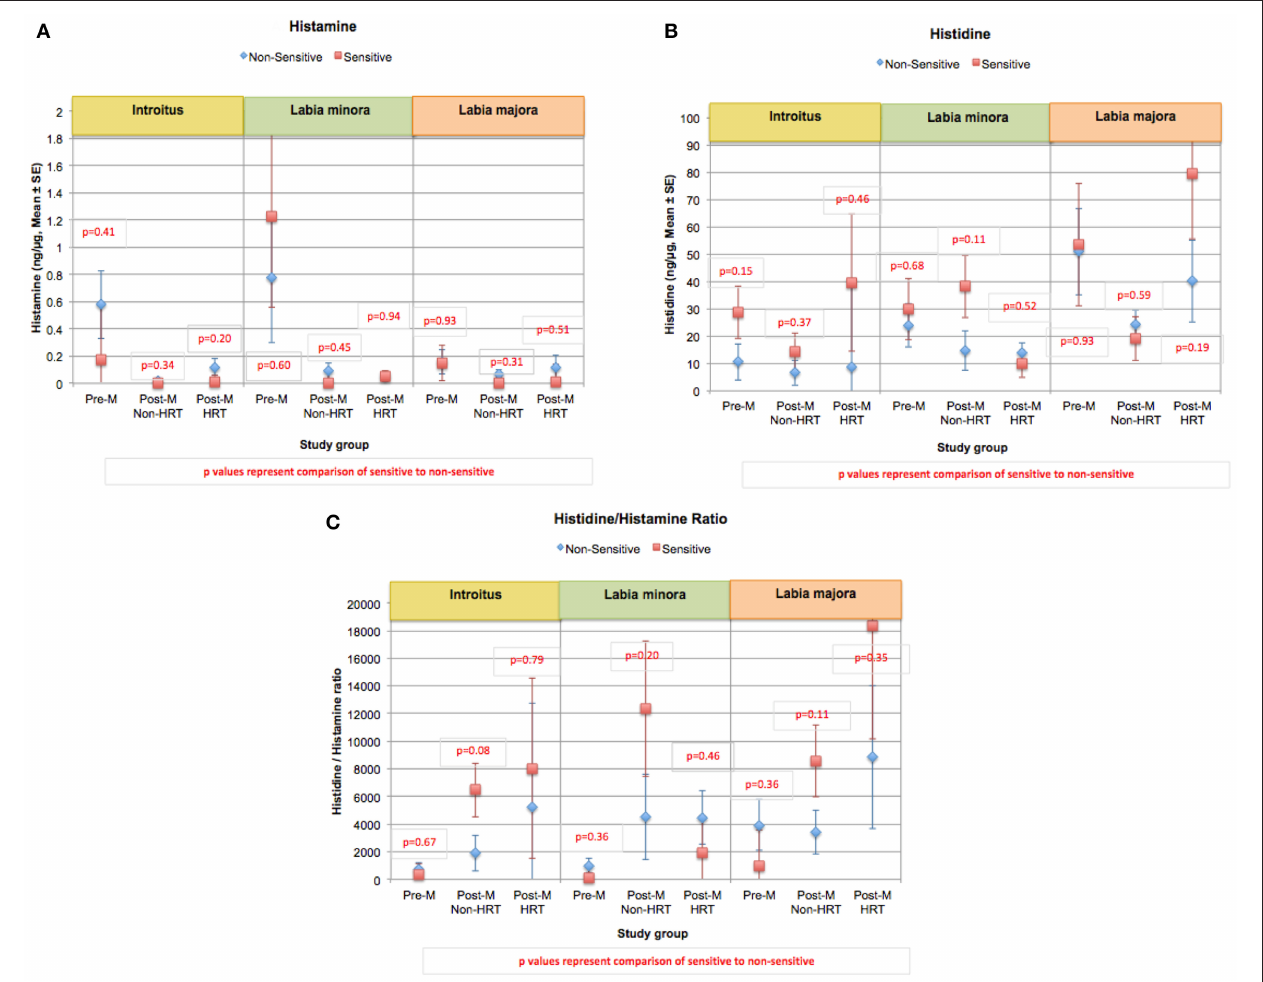
FIGURE 9 | Content of histamine, histidine, and the ratio of histidine/histamine at genital sites among women with sensitive genital skin. In the study to evaluate biomolecular and physical measures of the urogenital skin, histamine, histidine, and the ratio of histidine/histamine were evaluated. Results of analyses of the Pre-M and Post-M Non-HRT groups are presented for those who did not have sensitive genital skin compared to those declaring sensitive skin using a mixed linear model. (A) Mean histamine, (B) mean histidine, (C) mean of the ratios of